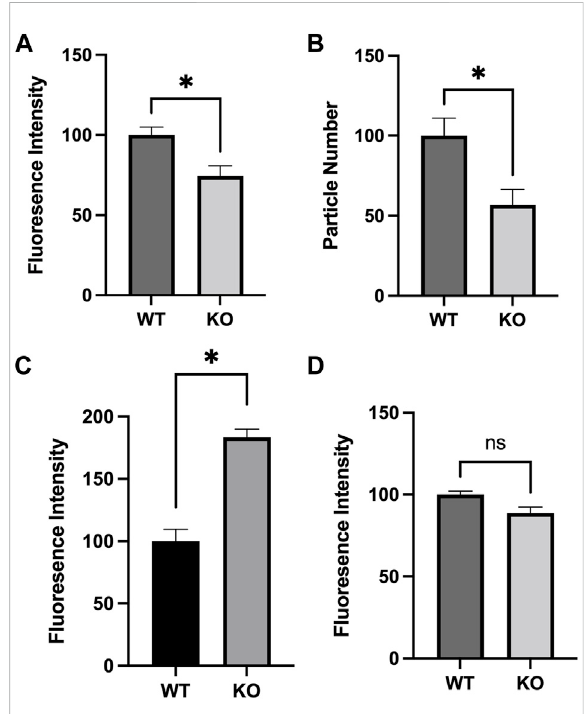
FIGURE 1 Altered mitochondrial characteristics in Sirt3-KO mouse embryonic fi broblasts. Histograms show the mean and SEM of (A) mitochondrial mass, (B) count, (C) Ca 2+ concentration, and (D) membrane potential measured using fl ow cytometry and confocal microscopy. MEFS generated from Sirt3-KO mice show signi fi cant decreases in mitochondrial size and number, increased mitochondrial Ca 2+ concentration. No difference in mitochondrial membrane potential was detected. Asterisks denote statistical signi fi cance ( p < 0.05) between the indicated groups ( n = 4 independent cultures) (Student t